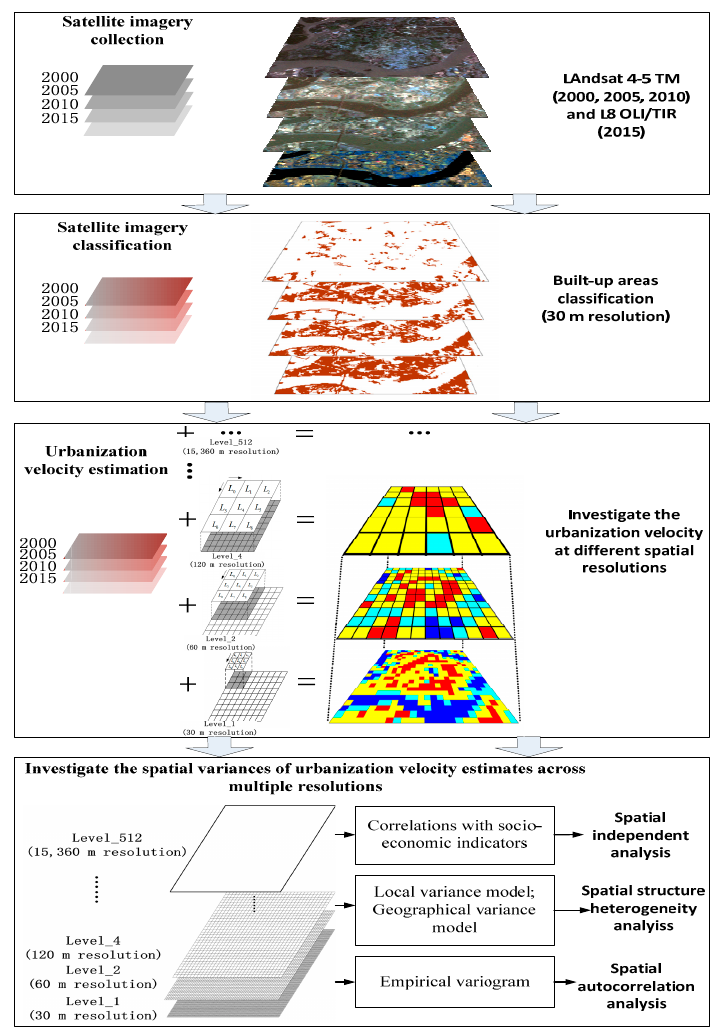
Figure 2. Schematic evaluation of urbanization velocity analysis for different spatial resolutions.